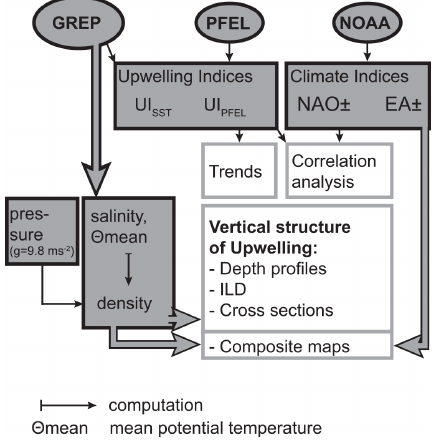
Figure 1. Flow chart of the data sources for the vertical structure of the ocean (GREP: Global Reanalysis Ensemble Product data by Copernicus), the upwelling indices (UI; PFEL: Pacific Fisheries En- vironmental Laboratory by NOAA), the climate patterns (NOAA: National Oceanic and Atmospheric Administration; NAO: North Atlantic Oscillation; EA: East Atlantic pattern), and the processing sequence (ILD: isothermal depth